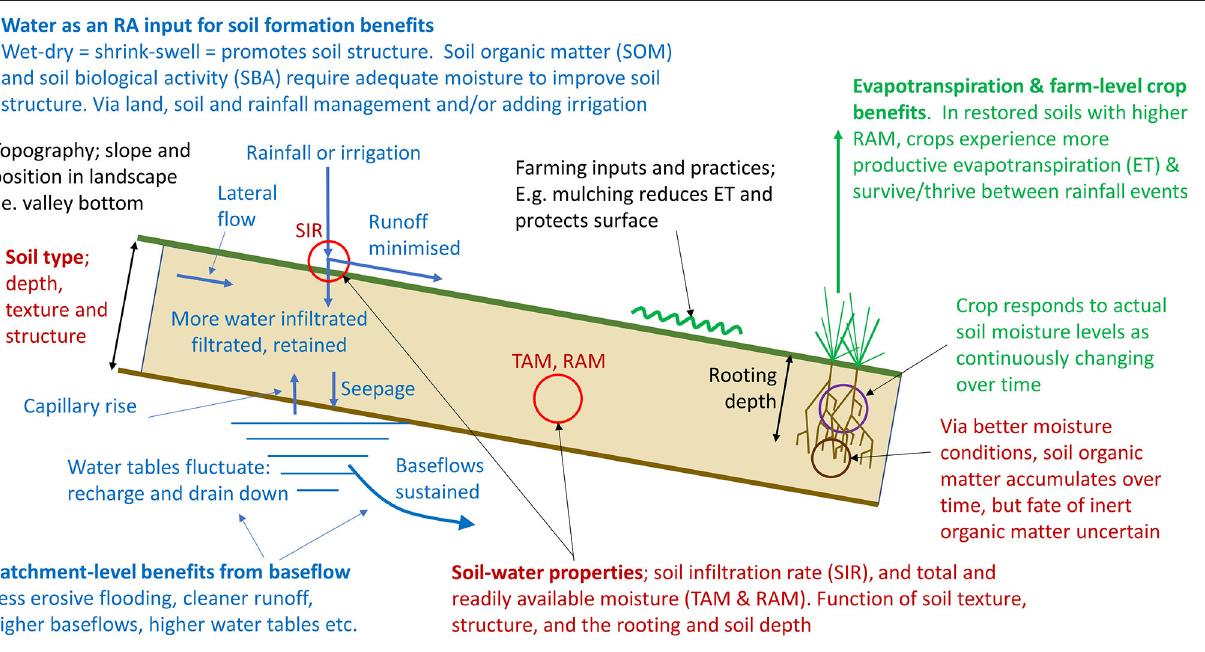
FIGURE 1 | Benefits for regenerative agriculture arising from the soil-water properties of readily available moisture and